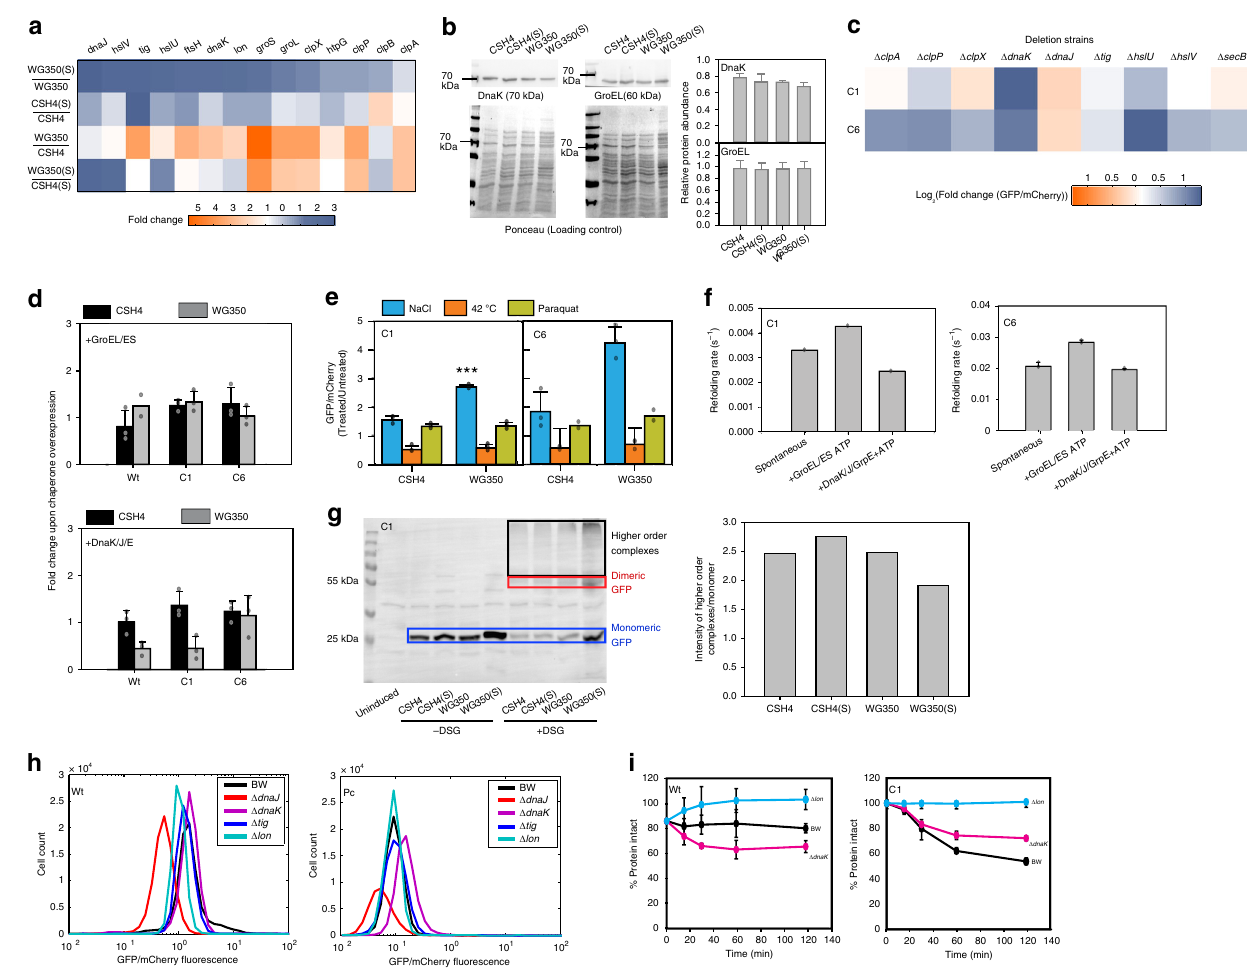
WG350(S)WG350(S) Fig. 5 Folding of isolated mutants is independent of molecular chaperones. a Heatmap representing relative quanti fi cation of transcripts encoding proteostasis components in WG350 and CSH4 in presence and absence of 350 mM NaCl. b Immunoblot (left panel) and image-based quanti fi cation (right panel) of DnaK and GroEL in CSH4 and WG350 in presence and absence of 350 mM NaCl ( p -value > 0.05). Mean is plotted with standard deviation as error bars from four biological replicates. c Heatmap representing Wt GFP normalized log 2 fold-change in GFP/mCherry fl uorescence in deletion strains against that in BW for Wt, C1, and C6 GFP. d Bar graph representing mean of GFP/mCherry fl uorescence of Wt, C1, and C6 GFP in CSH4 or WG350 with and without plasmids overexpressing either GroEL/ES (top) or DnaK/J/E (bottom) ( p -value > 0.05). e Bar graph representing GFP/mCherry fl uorescence of Wt, C1, and C6 GFP in CSH4 and WG350 in absence or presence of external stressors (42 °C — heat shock, 80 μ M Paraquat- oxidative stress, 350 mM NaCl - osmotic stress). Mean is plotted with signi fi cance calculated using 2-sided Students ’ t -test (* p -value 0.017; *** p -value 0.00007). f Bar graph for mean of refolding rate for unfolded C1 and C6 GFP in presence and absence of 400 nM DnaK/800nM DnaJ/400 nM GrpE or 400 nM GroEL/800 nM GroES. g Immunoblot for GFP showing recruitment of nascently formed C1 GFP into monomeric GFP (blue box), dimeric GFP (red box) and higher order complexes (black box). The ratio of GFP in higher order complex to the amount in monomeric state is shown in bar graph. h Histogram for GFP/mCherry fl uorescence of Wt and pool of GFP mutants (Pc) in BW, molecular chaperone ( Δ dnaJ, Δ dnaK, Δ tig ) and protease ( Δ lon ) knockout strains. i Plot for quanti fi cation of intact GFP in Chloramphenicol-chase for Wt and C1 GFP in BW, Δ dnaK , and Δ lon strains. Mean from three biological replicates is plotted. For d , e , f , and i : Standard deviations are plotted as error bars from three biological replicates. Also see Supplementary Fig. 4 (Source data are provided as source data fi le Fig.